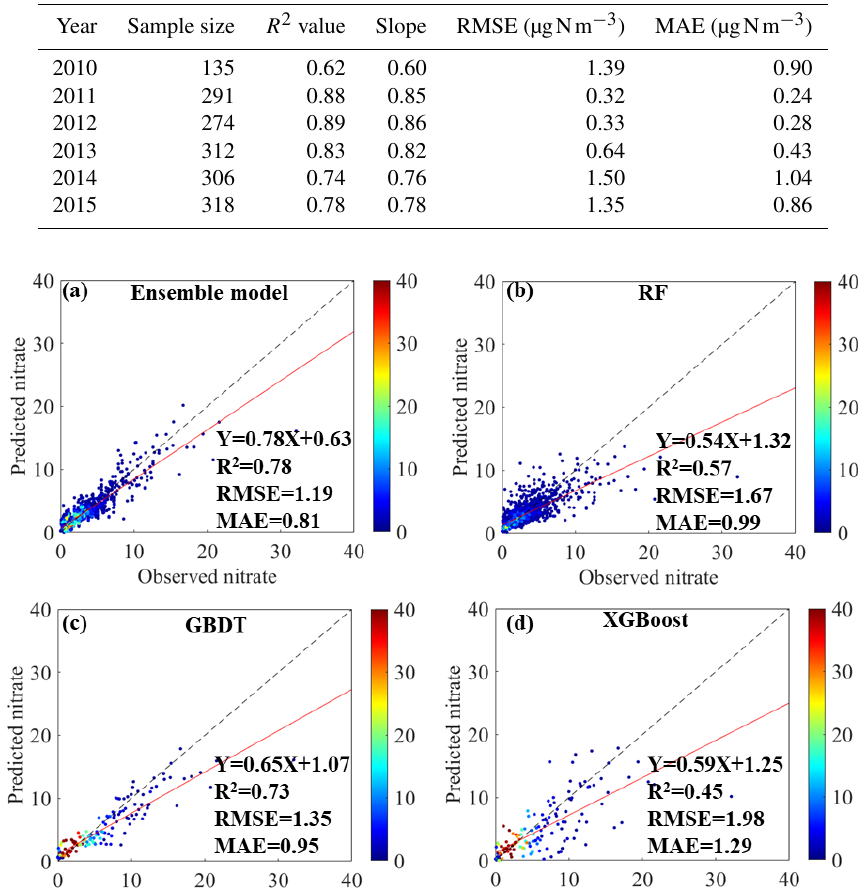
− estimation (unit: µgNm − 3 ) across China for the ensemble 3